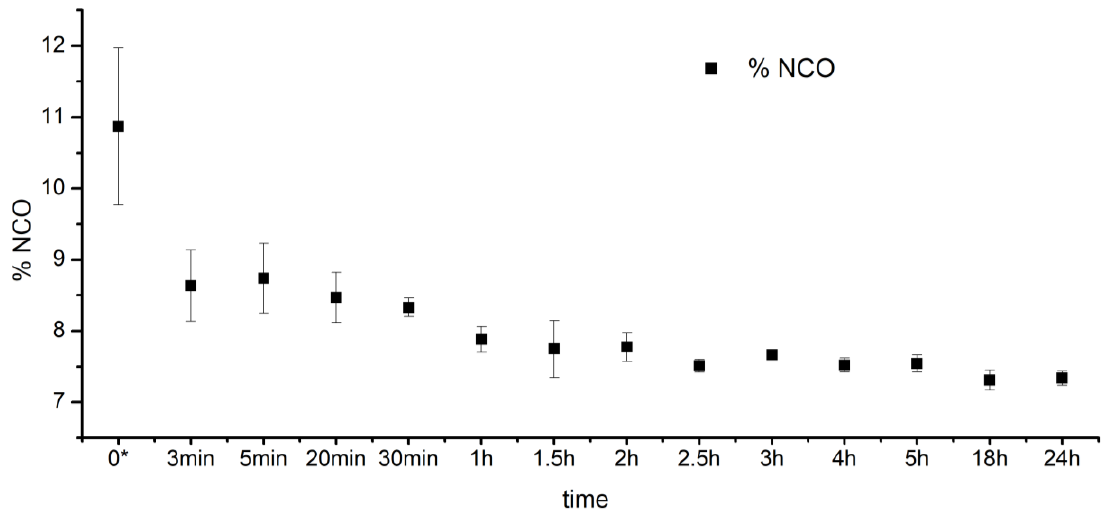
Figure 2. The changes of the isocyanate groups content (F NCO , %) over reaction time between PEBA and HDI (prepolymerization step); * time “0” is related to the moment when the PEBA and HDI were mixed together in a whole volume of the reactive mixture .